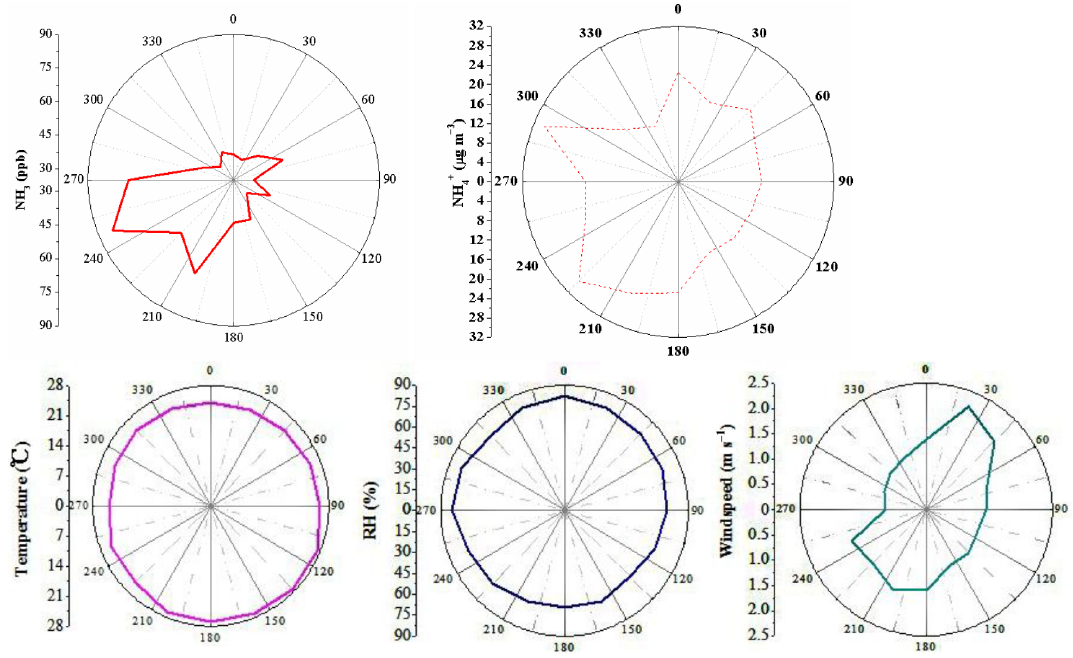
Figure 11. The average NH 3 , NH + , and meteorological data roses in different wind sectors during summer 2013. 4